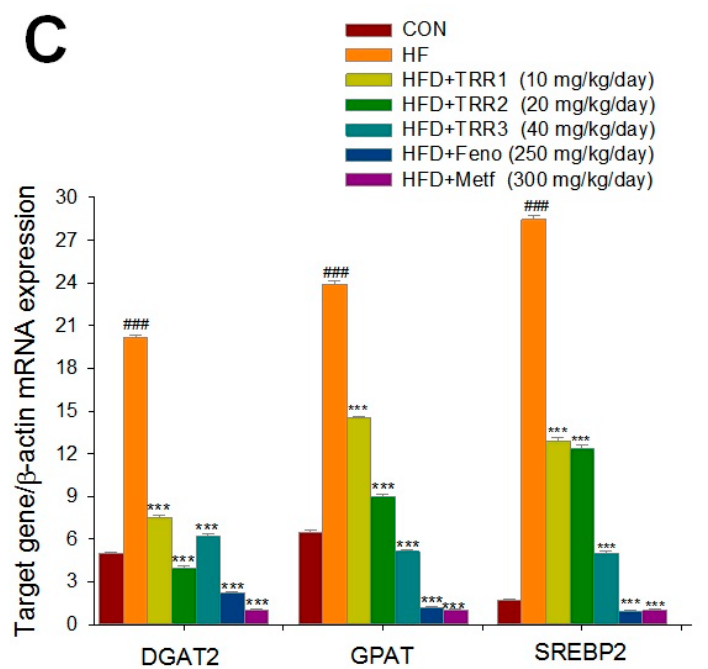
Figure 5. Semiquantative reverse transcription polymerase chain reaction (RT-PCR) analysis on phosphenolpyruvate carboxykinase (PEPCK), glucose-6-phosphatase (G6Pase), sterol regulatory element-binding protein 1 (SREBP1c), diacylglycerol acyltransferase 2 (DGAT2), glycerol-3-phosphate acyltransferase (GPAT), and sterol regulatory element-binding protein 2 (SREBP2) messenger RNA (mRNA) levels in liver tissue of the mice receiving eburicoic acid (TRR) by oral gavage for 4 weeks. ( A ) representative image. ( B , C ) Quantification of the ratio of target gene to GAPDH mRNA expression. All values are means ± SE ( n = 9). ### p < 0.001 compared with the control